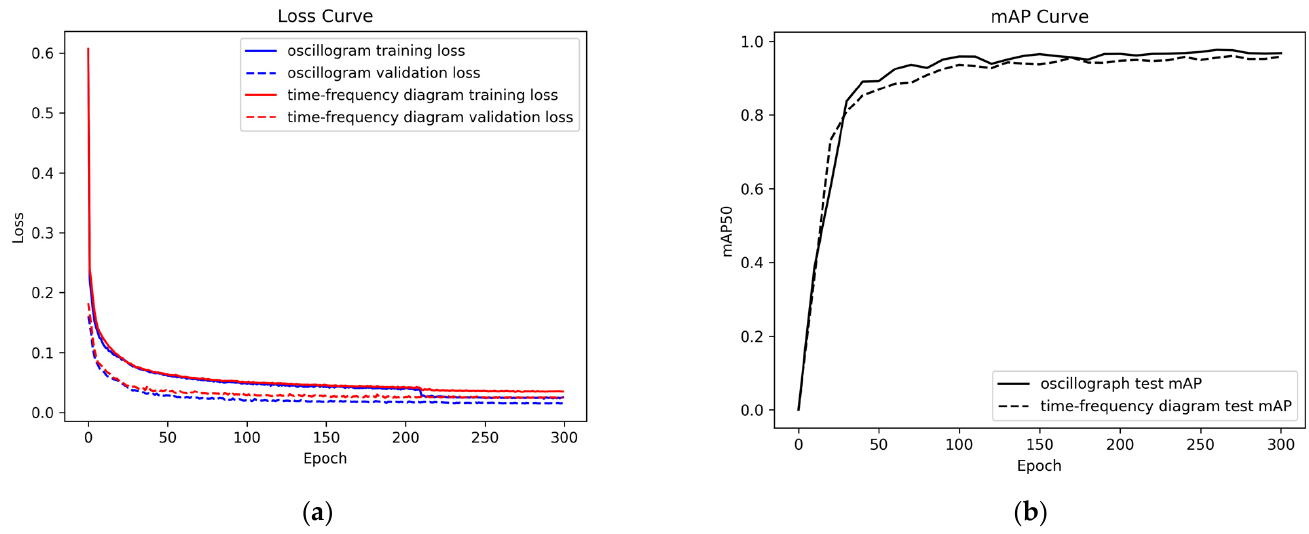
Figure 13. The curve change of the dataset; ( a ) loss curves for the training and validation sets; and ( b ) mAP curves for the test sets. Table 2. Test results of different datasets (confidence threshold is 0.5 and IOU threshold is